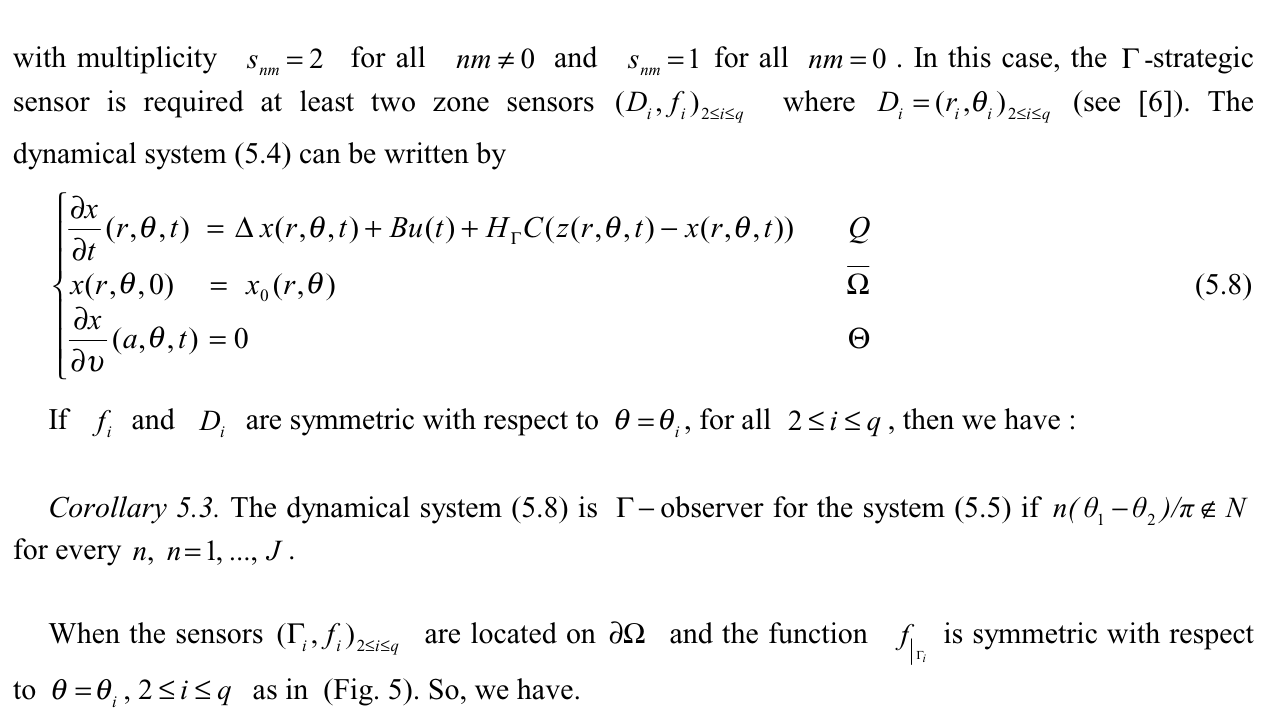
, pp of internal (boundary) zone 21